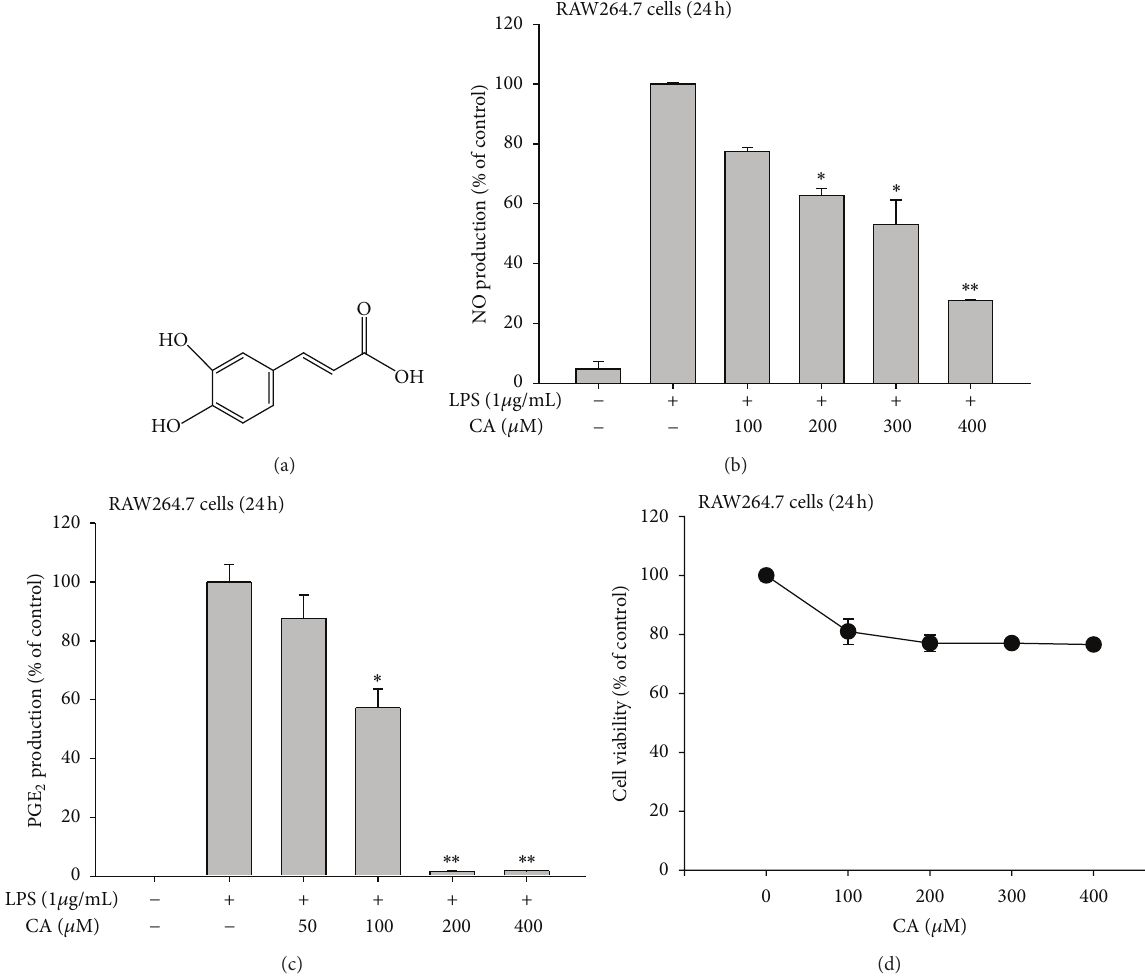
Figure 1: Effect of CA on NO and PGE 2 production and viability in LPS-treated RAW264.7 cells. (a) The chemical structure of CA. ((b) and (c)) Levels of NO and PGE 2 were determined by the Griess assay and EIA, respectively, from supernatants of RAW264.7 cells that had been treated with CA (0 to 400 𝜇 M) in the presence or absence of LPS (1 𝜇 g/mL) for 24h. (d) RAW264.7 cell viability was determined by MTT assay. ∗ 𝑃 < 0.05 and ∗∗ 𝑃 < 0.01 , compared to the